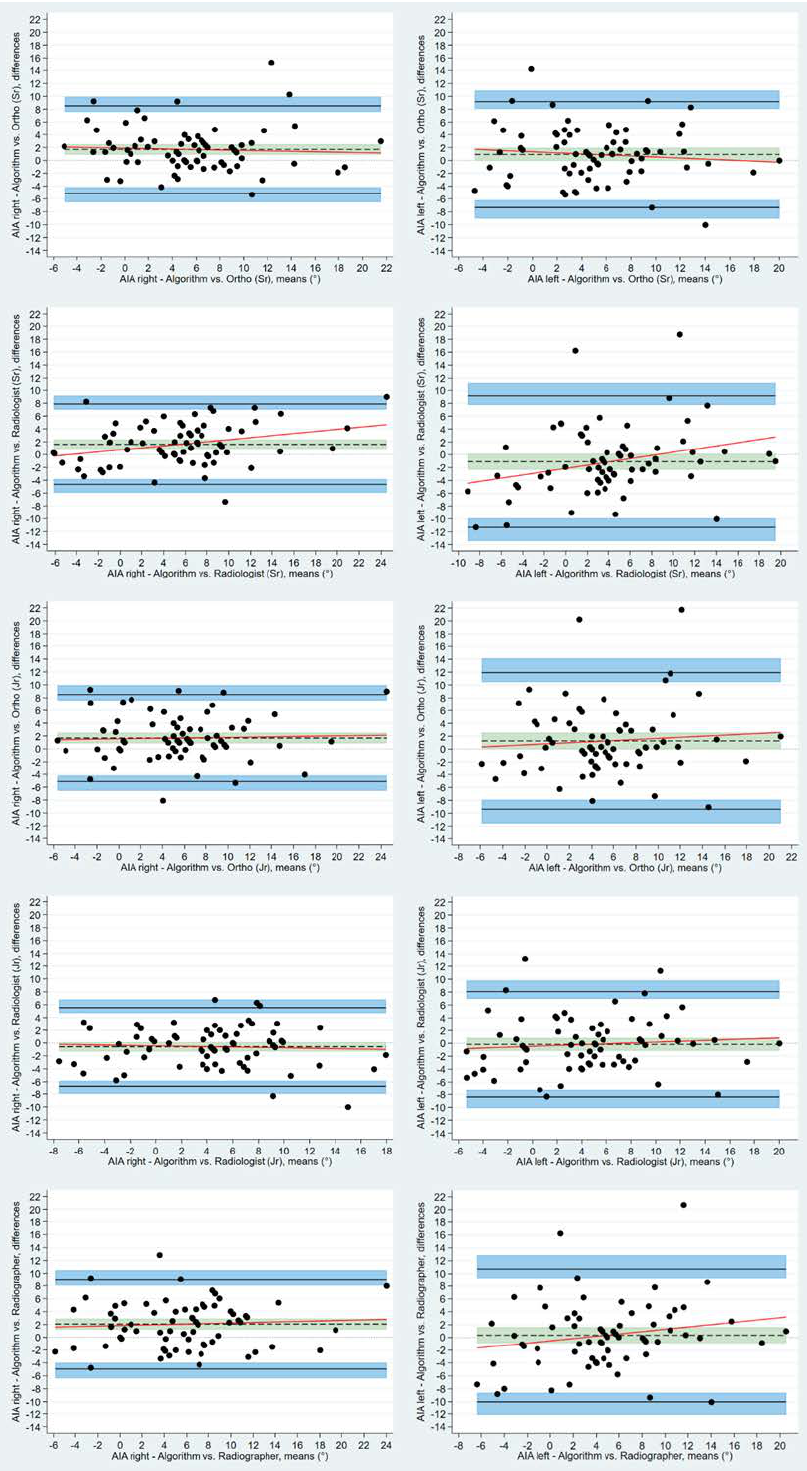
Figure 6. Bland-Altman plots with Limits of Agreement and respective 95% CI depicting agreement between human readers and algorithm for acetabular index angle. Differences between measurements are plotted against the mean of the measurements. Solid black lines depict upper and lower limits of agreement. Shaded blue areas depict the 95% confidence intervals. Dotted black lines are the mean measured differences with the shaded green areas illustrating the 95% confidence intervals.